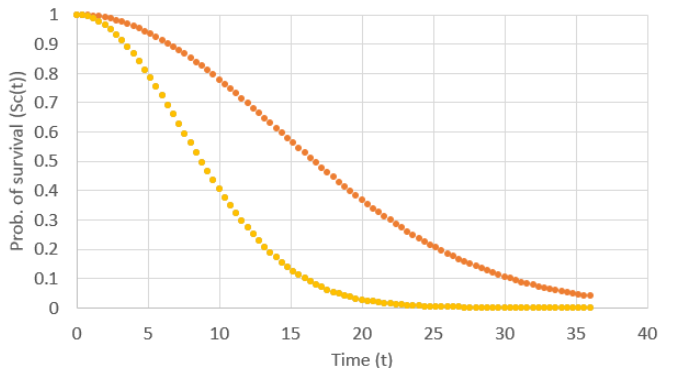
Figure 6. Two Weibull curves, one for a new component (upper) and one for a fixed component